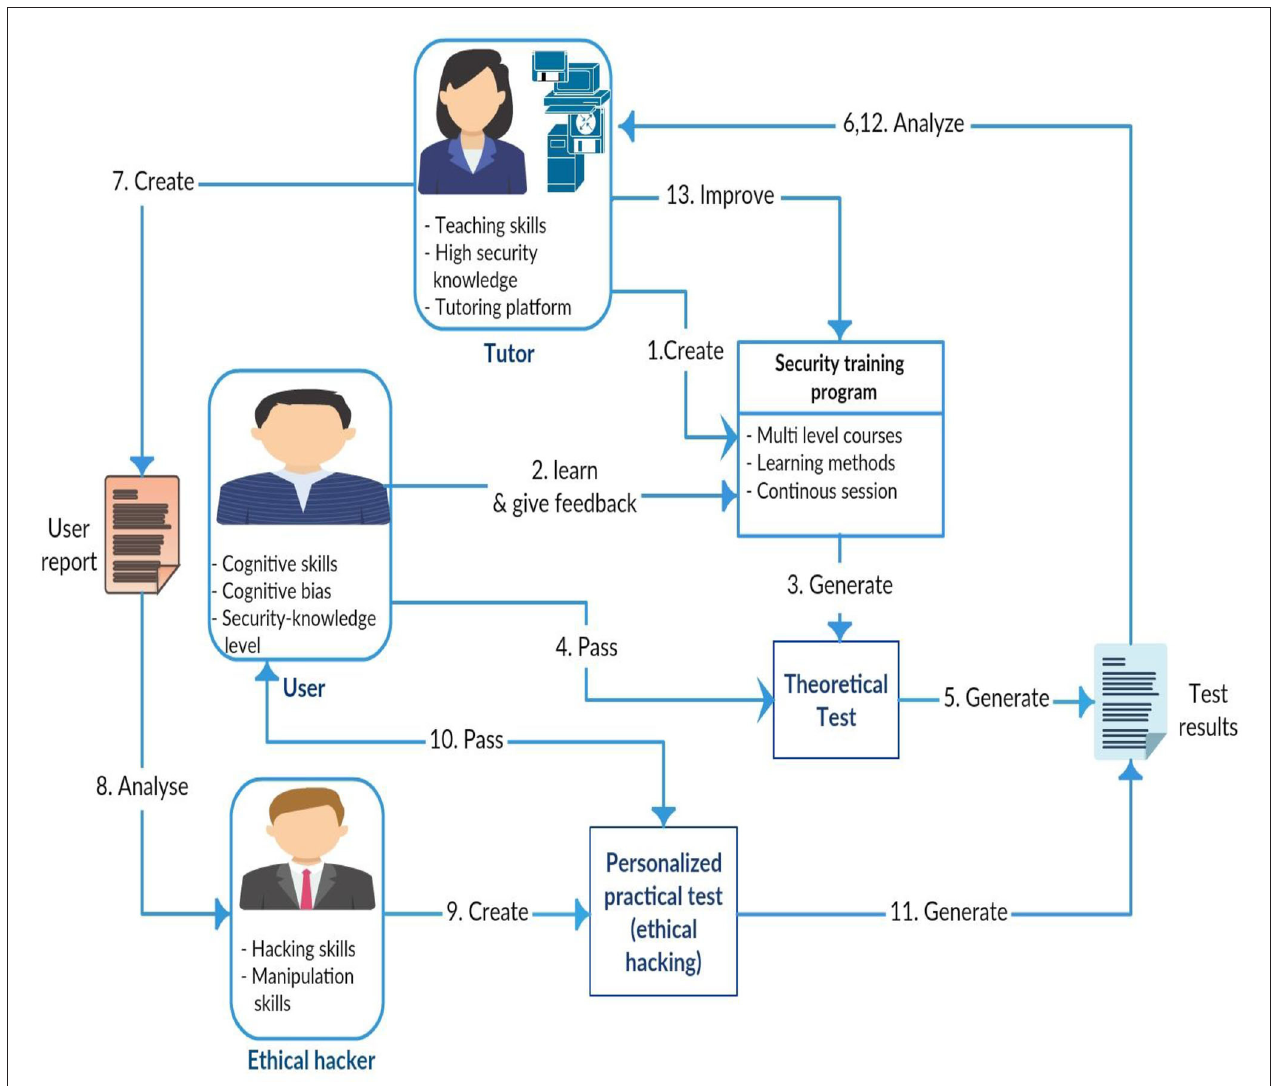
FIGURE 4 | The architecture of security training model